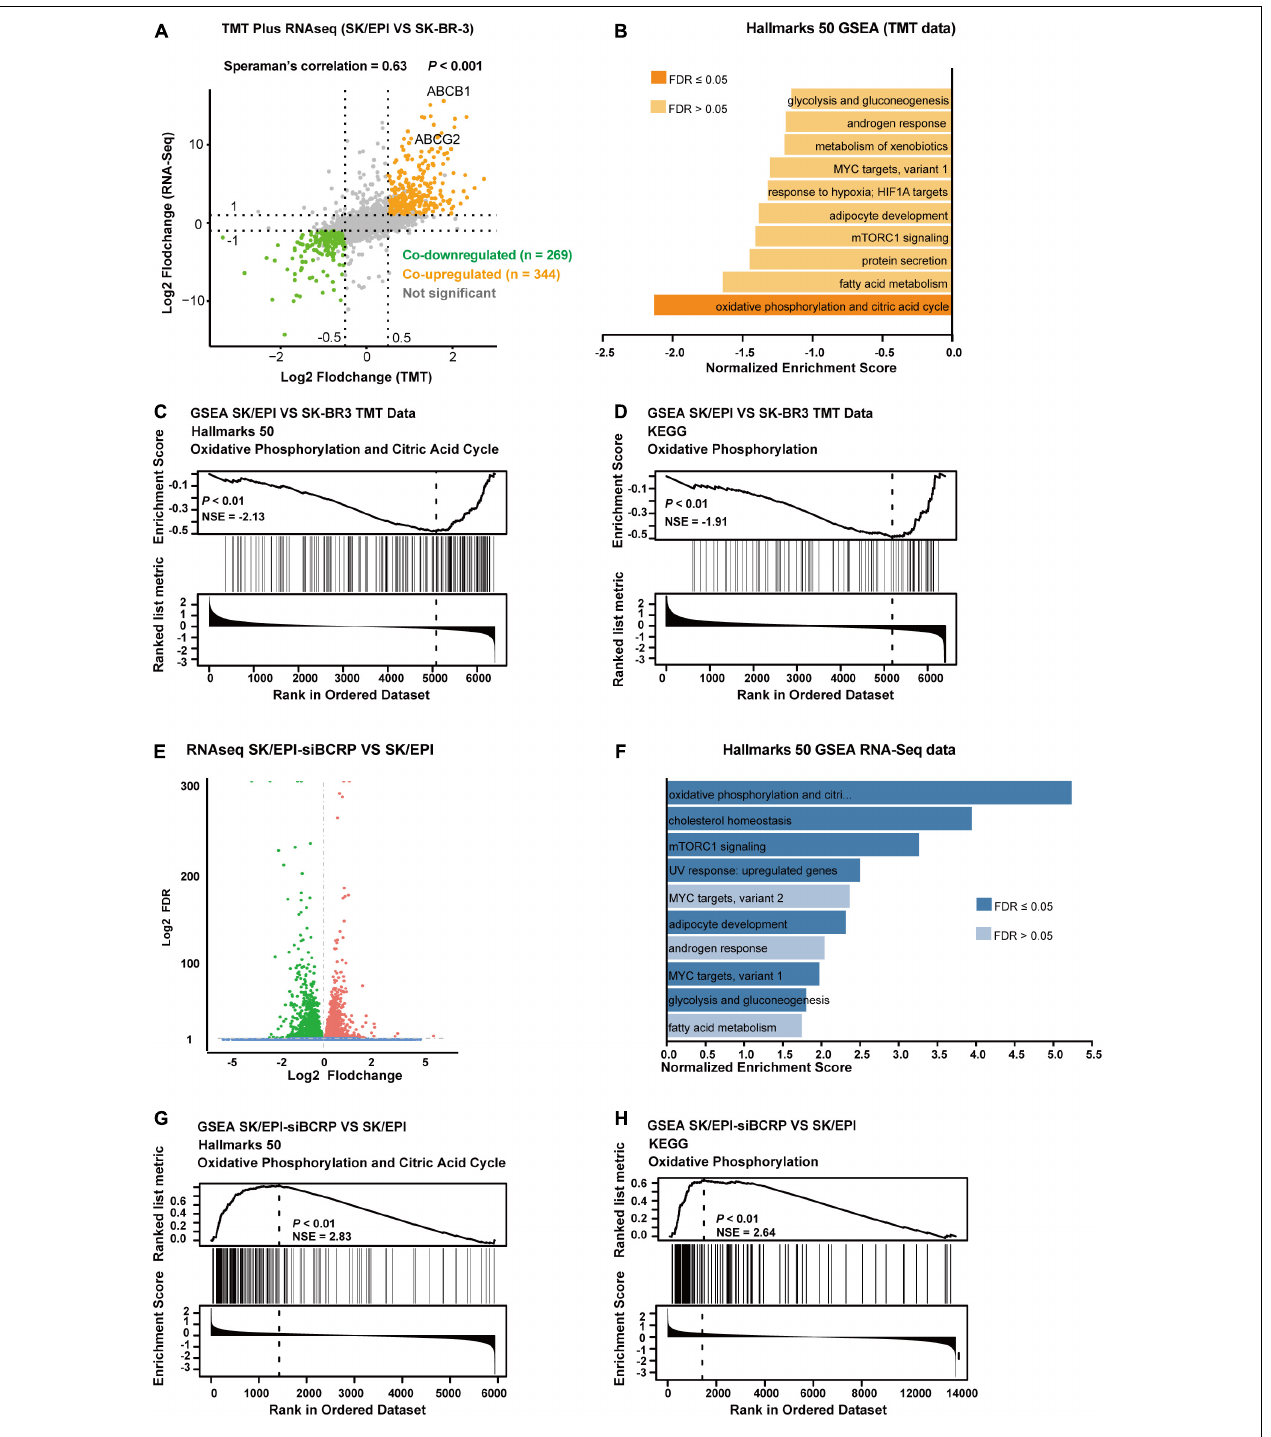
FIGURE 4 | BCRP inhibits OXPHOS in drug-resistant breast cancer cells. (A) Nine-quadrant plot shows the differentially expressed transcripts/proteins in RNA-Seq and TMT-based proteomics. The co-upregulated and co-downregulated transcripts/proteins are shown as red dots and blue dots, respectively. (B) GSEA shows the top 10 downregulated signal pathways in SK/EPI cells compared with that in parental cells. (C,D) GSEA shows that phosphorylation- and citric acid cycle-related proteins were enriched in parental cells (SK-BR-3) compared with drug-resistant cells (SK/EPI) using Hallmarks 50 (C) and KEGG (D) gene sets. (E) Volcano plot shows differentially expressed genes in BCRP-silenced SK/EPI cells versus SK-BR-3 cells. (F) GSEA shows the top 10 upregulated signaling pathways in BCRP-silenced SK/EPI cells compared with that in control cells. (G,H) GSEA shows that phosphorylation- and citric acid cycle-related proteins were enriched in BCRP-silenced SK/EPI cells compared with control cells using Hallmarks 50 (G) and KEGG (H) gene sets.